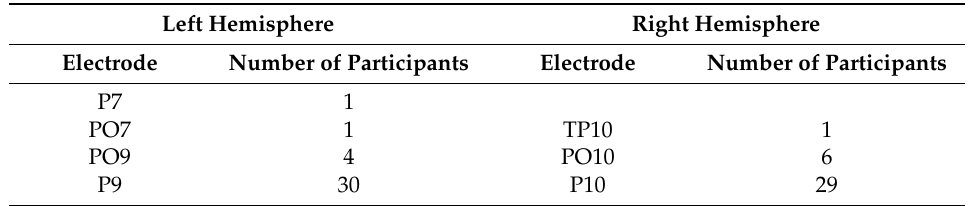
Table 2. Participant distribution for maximal N170 peak electrodes (all conditions) in the left and right